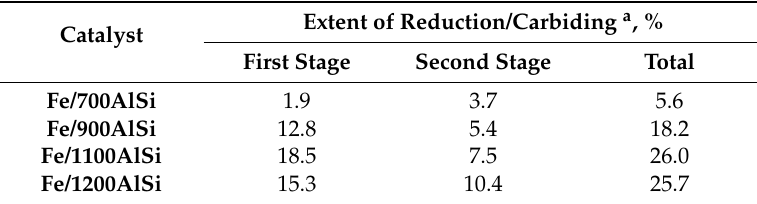
Figure 4. Syngas-TPR for Fe catalysts with different support calcination temperatures focused on two stages of weight loss (inverted). Table 4. Weight losses of Fe catalysts supported on AlSi calcined at different temperatures during reduction and carbiding stage.